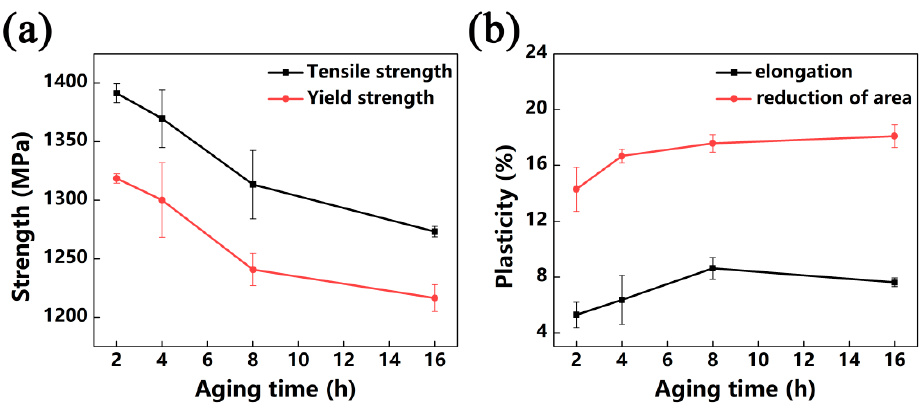
Figure 14. Tensile properties of the alloy was solution-treated at 780 °C and aged at 540 °C for different lengths of time: ( a ) tensile strength and yield strength of the alloy; ( b ) elongation and reduction of area of the alloy.